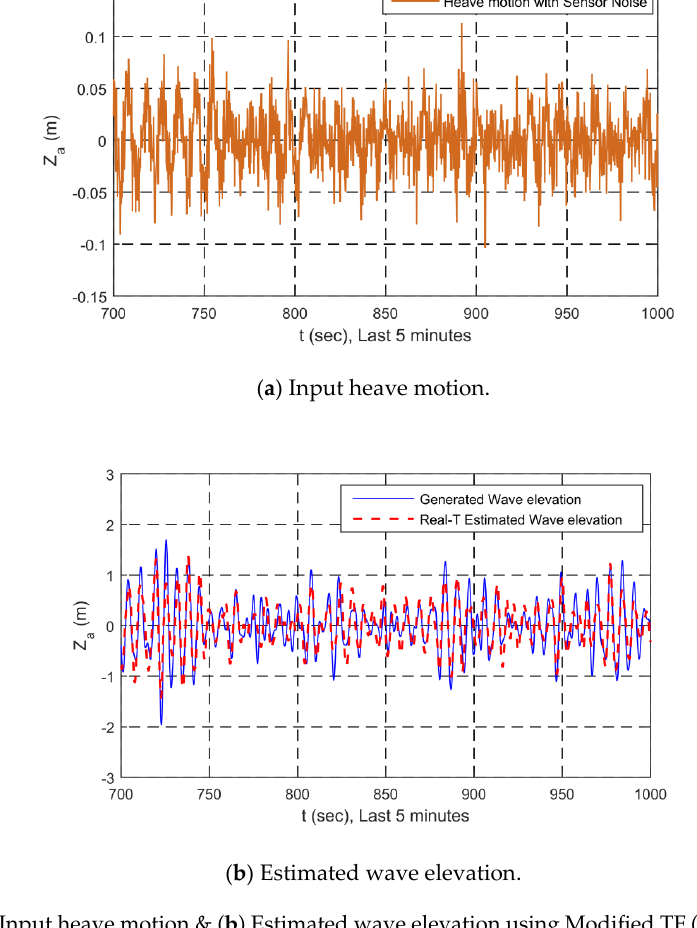
Figure 18. ( a ) Input heave motion & ( b ) Estimated wave elevation using Modified TF (Hs = 2 m, Tp = 7 s, Frequence: 0.1~2.0 rad/s).